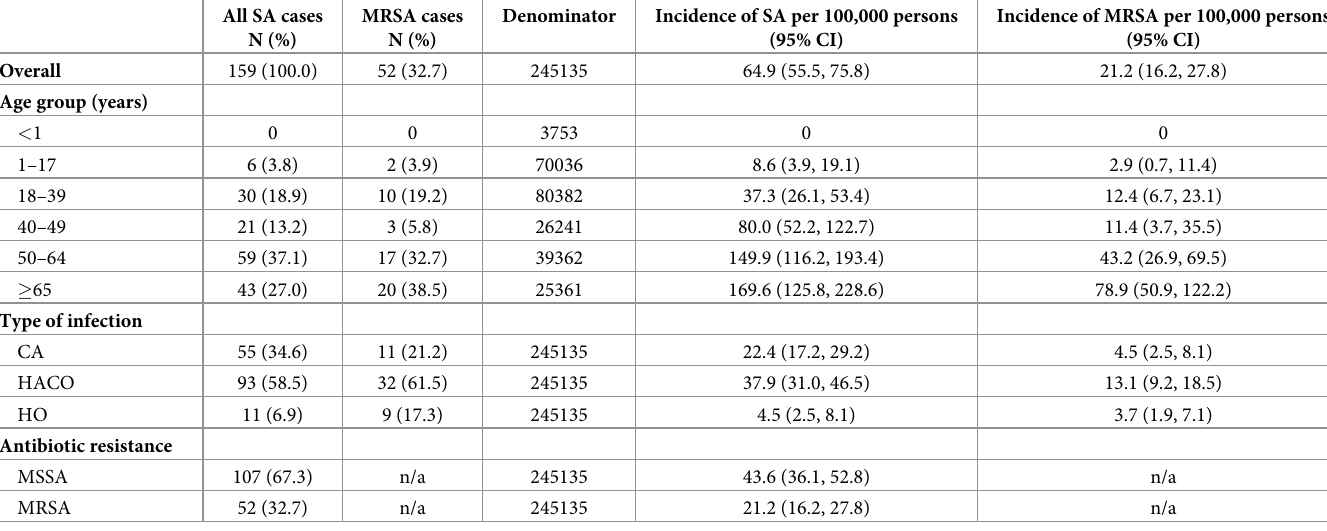
Table 2. Incidence of invasive Staphylococcus aureus disease by age, type of infection, and antibiotic resistance, Navajo Nation, May 2016 –April 2017. All SA cases N